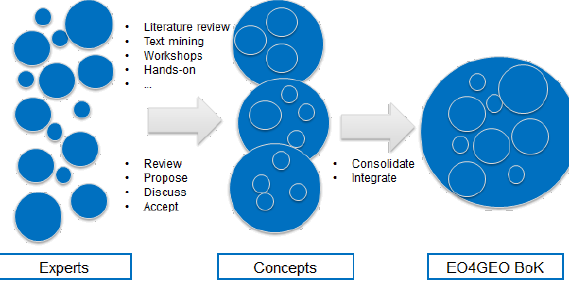
Figure 1. Workflow of the EO4GEO BoK development and its main elements: experts and concepts